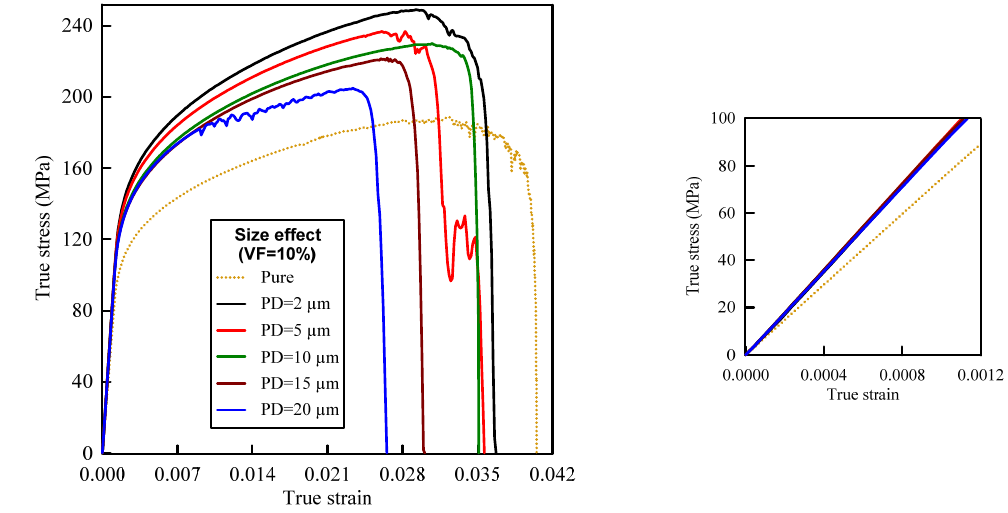
Figure 12. Representation of microstructure of A359 alloy matrix and SiC particles with different sizes (10% VF).